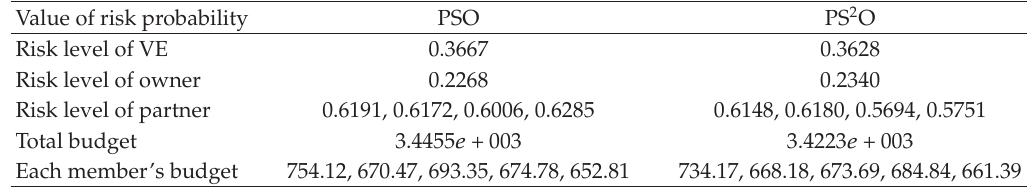
Table 8: Simulation results of both